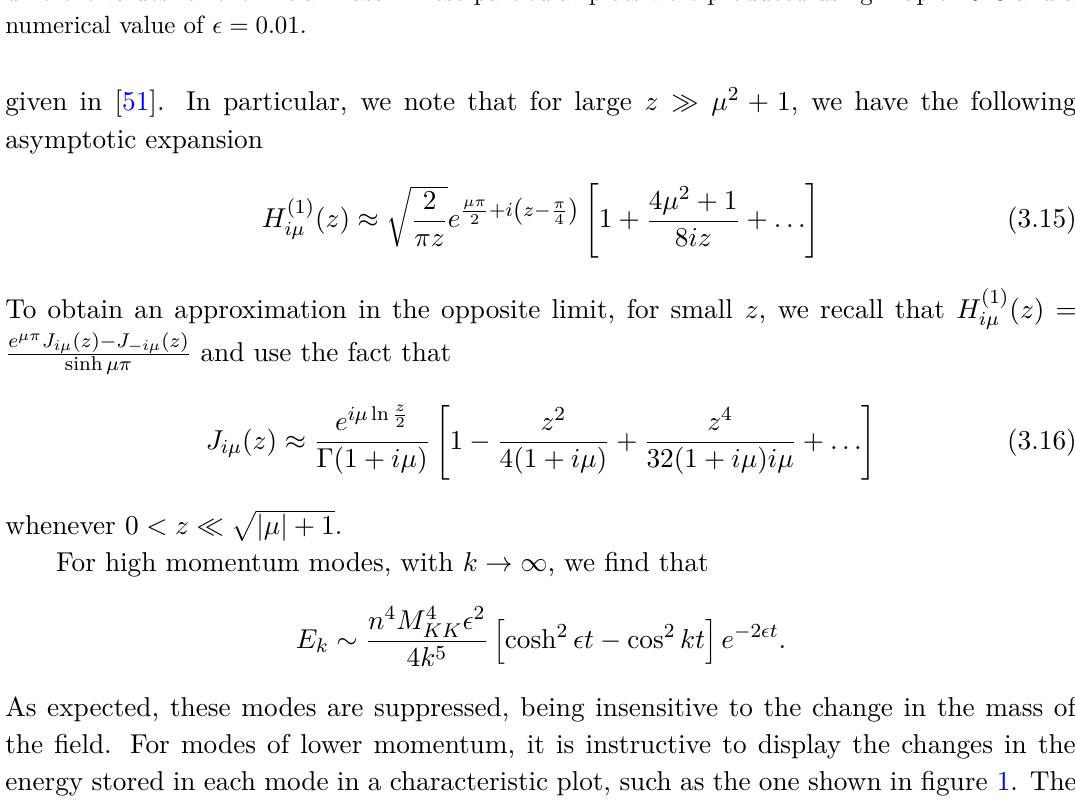
Figure 1 . Plot of energy versus time for a range of scalar modes of different momentum and different values for the initial mass. These particular plots were produced using Maple 2020 and a numerical value of (cid:15) = 0 . 01